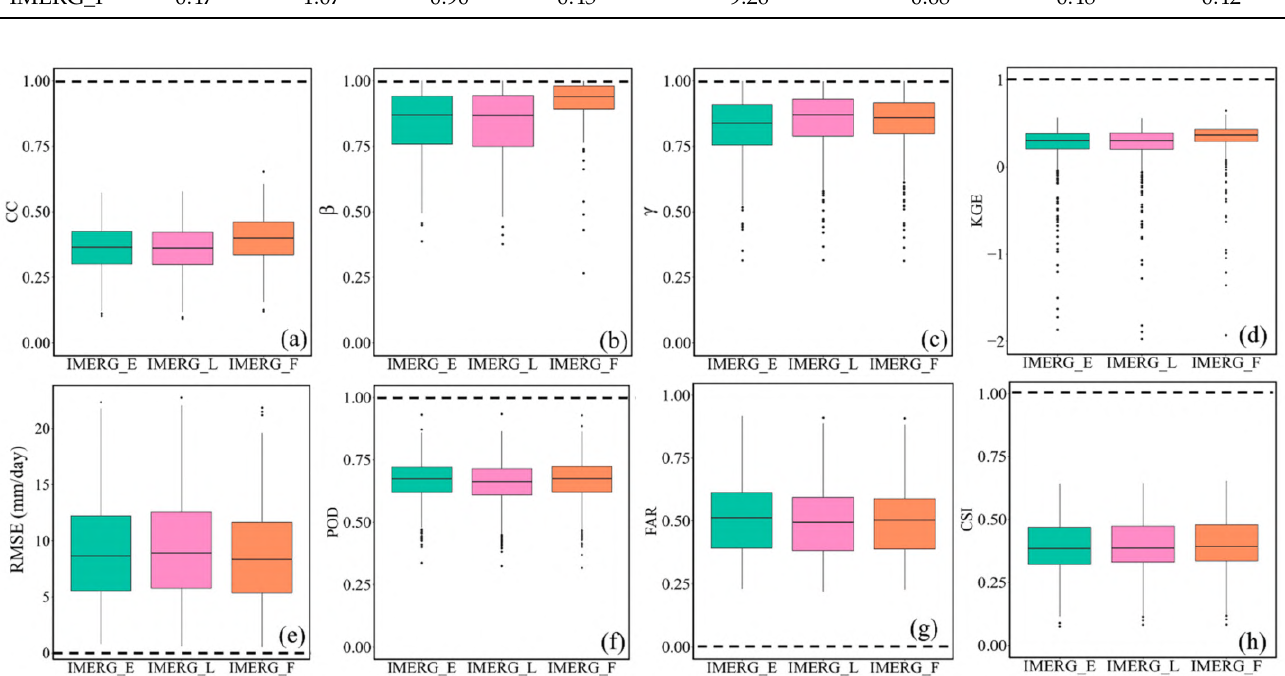
Figure 4. Boxplots of CC ( a ), β ( b ), γ ( c ), KGE ( d ), RMSE ( e ), POD ( f ), FAR ( g ) and CSI ( h ) at daily scale from 2008 to 2017. The bottom and top edges of the boxes indicate the 25th and 75th percentiles, respectively. The central black line indicates the median. The black dash line is the optimal